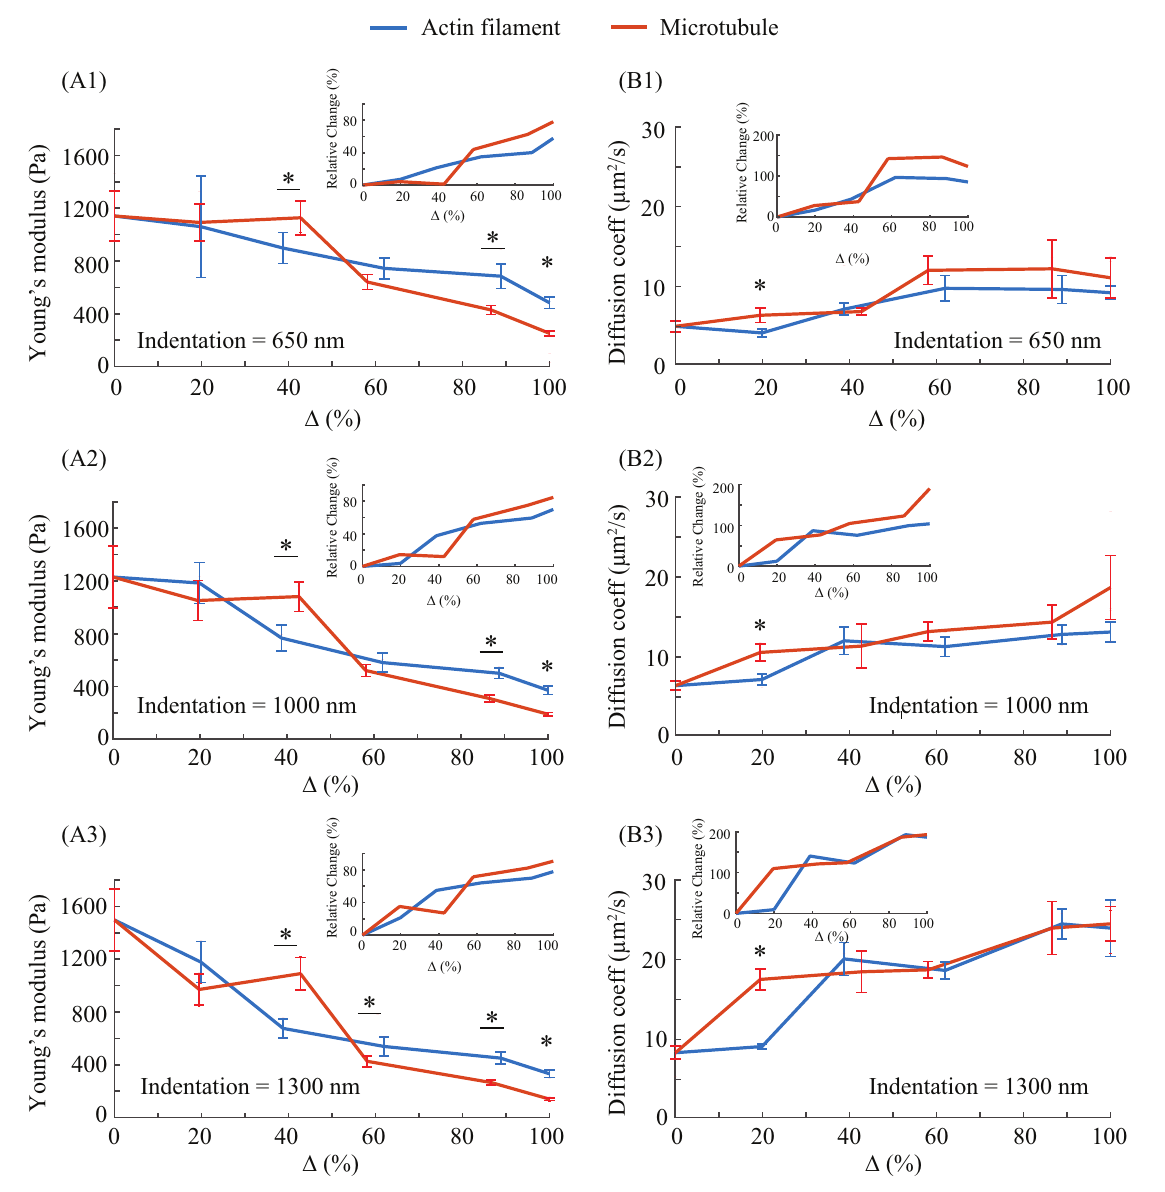
Figure 5. The cytoskeleton morphology intensity decrease percentage ( ∆ ) vs. the cellular ( A1 – A3 ) Young’s modulus and ( B1 – B3 ) diffusion coefficient of NIH/3T3 cells quantified at the indentation depths of 650, 1000, and 1300 nm, respectively. n ≥ 8. Error bar: standard error. Student’s t -test was performed to analyze the statistical difference: for each similar treatment concentration, data from the two drug treatments were compared. ∗ : p <